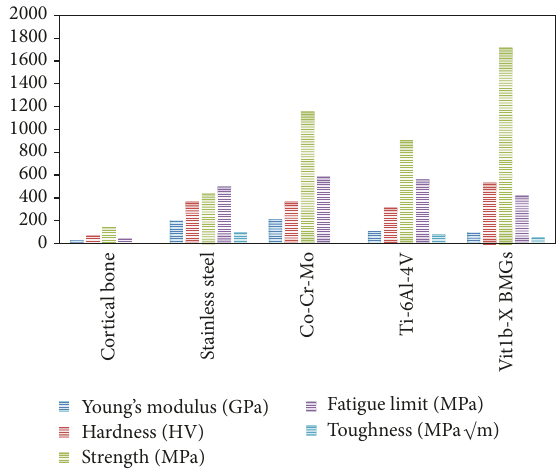
Figure 7: Comparison of mechanical properties of the cortical bone and the most commonly used metallic biomaterials [30, 58,